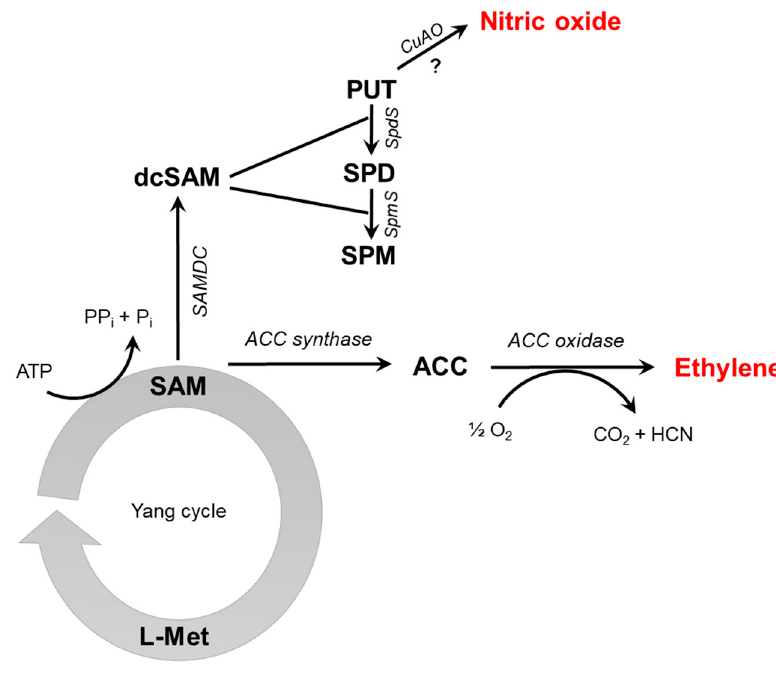
Figure 1. Schematic overview of ethylene synthesis intermediates (S-adenosyl-methionine, SAM; 1-aminocyclopropane-1-carboxylic acid, ACC) and enzymes (ACC synthase, ACC oxidase). The formation of nitric oxide through putrescine (PUT) oxidation by copper-amine-oxidase (CuAO) is also depicted; however, the question mark indicates that this mechanism requires further experimental evidence. Additional abbreviations: L-Met, L-methionine; SAMDC, SAM decarboxylase; dcSAM, decarboxylated SAM, SPD, spermidine; SpdS, spermidine synthase; SPM, spermine; SpmS, spermine